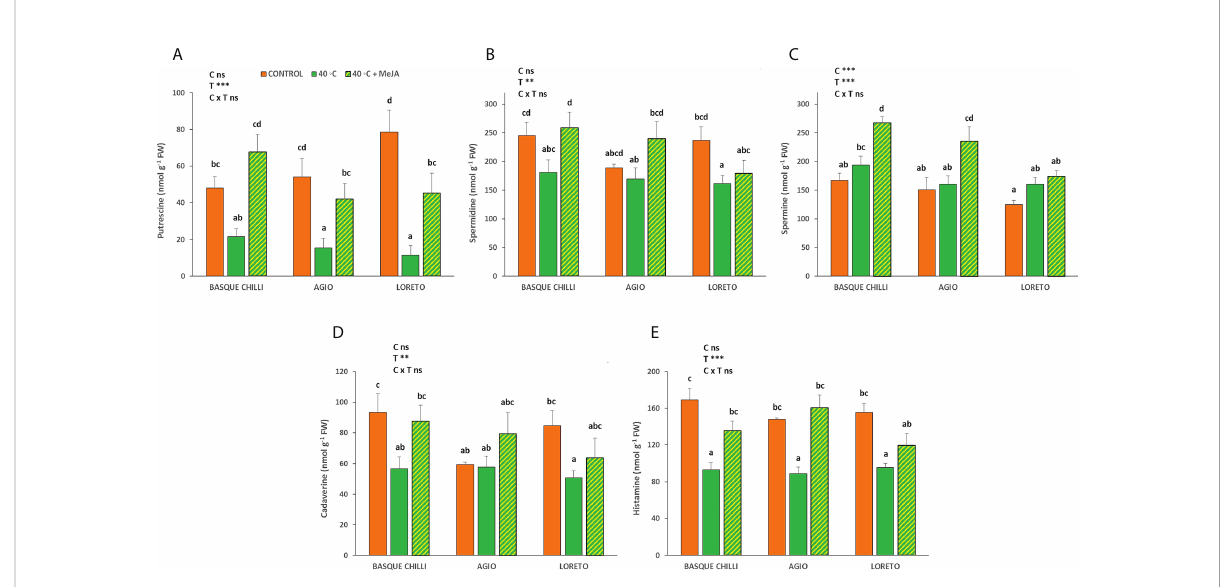
FIGURE 4 Effects of heat shock and MeJA on leaf polyamines ( (A) putrescine, (B) spermidine, (C) spermine, (D) cadaverine and (E) histamine) of the three pepper cultivars. Values are means ± SE. Different letters indicate signi fi cant differences between treatments according to Duncan ’ s test at the 95% con fi dence level. The ** refers to signi fi cant differences at the level of p ≤ 0.005; ***p ≤ 0.001; n.s., not signi fi cant. C is cultivar; T is